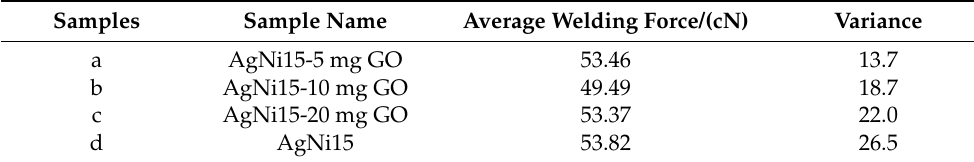
Table 2. Average welding force and variance of the Ag-graphene/Ni.